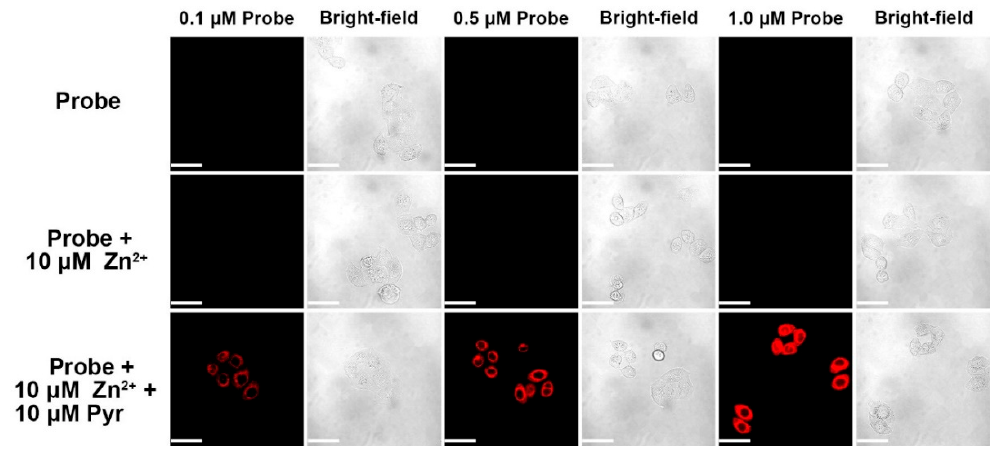
Figure 6. Fluorescence images of fluorescent probe A with concentration at 0.1 μ M, 0.5 μ M, and 1.0 μ M in HeLa cells. Cells were incubated with probe A with specific concentration for 30 min. Cells were then supplemented with either 10 μ M of zinc(II) chloride or 10 μ M each of zinc(II) chloride plus sodium pyrithione (Pyr) for 30 min before acquiring images. Scale bar: 50 μ m. λ ex : 635 nm.